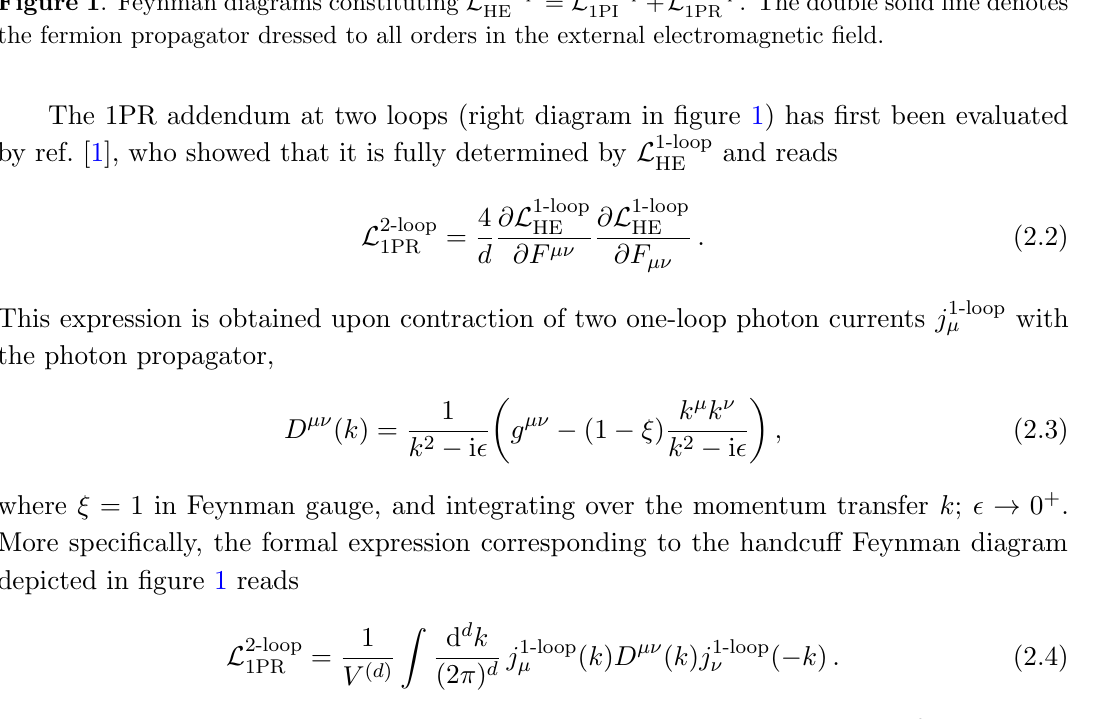
Figure 1 . Feynman diagrams constituting